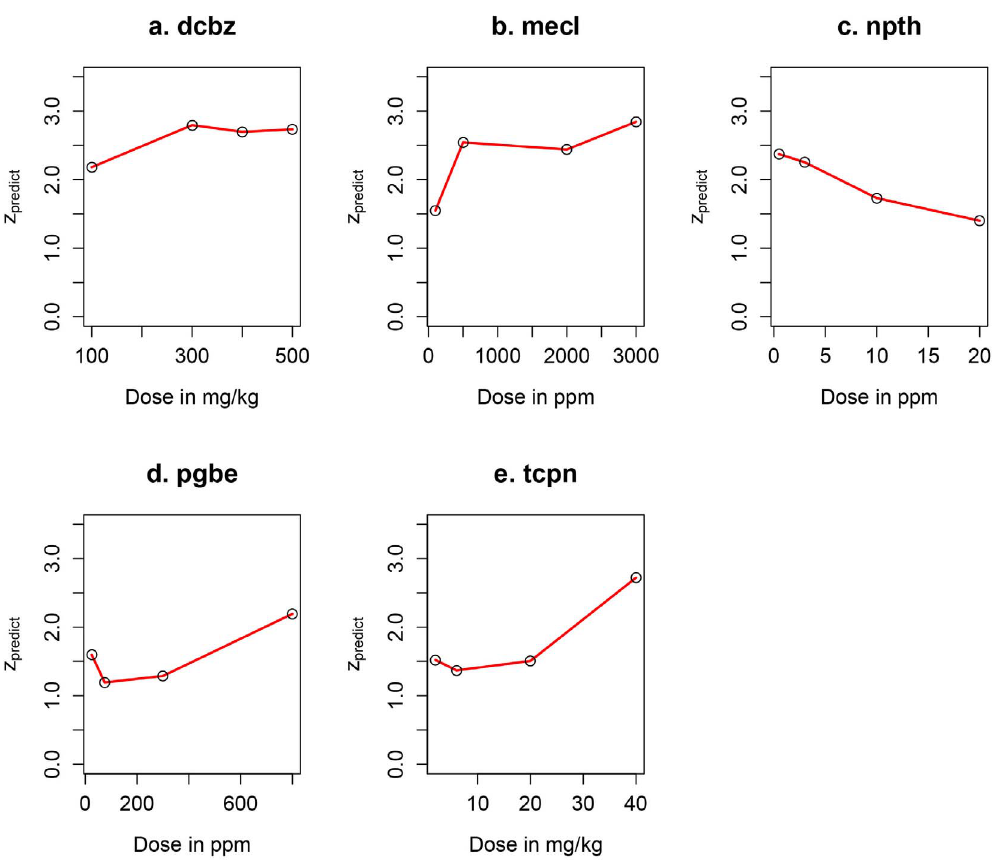
Figure 2. Dose-response predictions using the pathway-based prediction models for data of the chemicals tabulated in Table 2. Dose response predictions for five chemicals (a. dcbz, b. mecl, c. npth, d. pgbe and e. tcpn) treated at four different doses in mice.